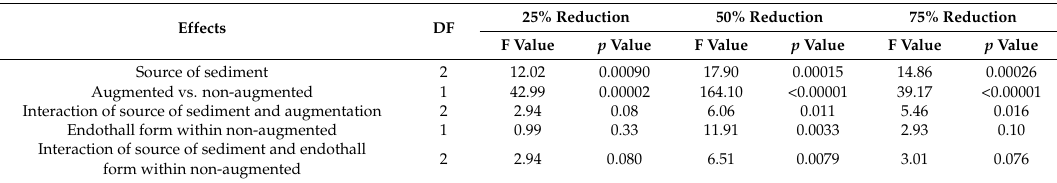
Table 10. Analyses of variance for treatment effects on the first day in which endothall isomer-1 had decayed by 25, 50 or 75% of its total decay. Analysis only includes mesocosms with sediment. Days are transformed to ranks with ties. All p values are calculated using permutation tests on the F statistic on rank transformed data. DF = Degrees of